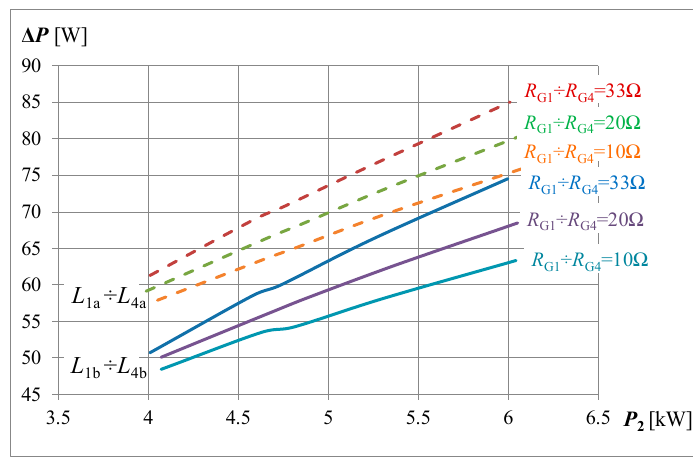
Figure 11. Power losses ( Δ P) of the converter obtained at various output power P 2 values and gate Figure 11. Power losses ( ∆ P) of the converter obtained at various output power P 2 values and gate resistance values ( R G1 – R G4 = 33 Ω ; = 20 Ω ; = 10 Ω ) and different types of input inductors ( L 1a – L 4a ; L 1b – resistance values ( R G1 – R G4 = 33 Ω ; = 20 Ω ; = 10 Ω ) and different types of input inductors ( L 1a – L 4a ; L 4b ); f s = 125 kHz, D = 0.45. L 1b – L 4b ); f s = 125 kHz, D =